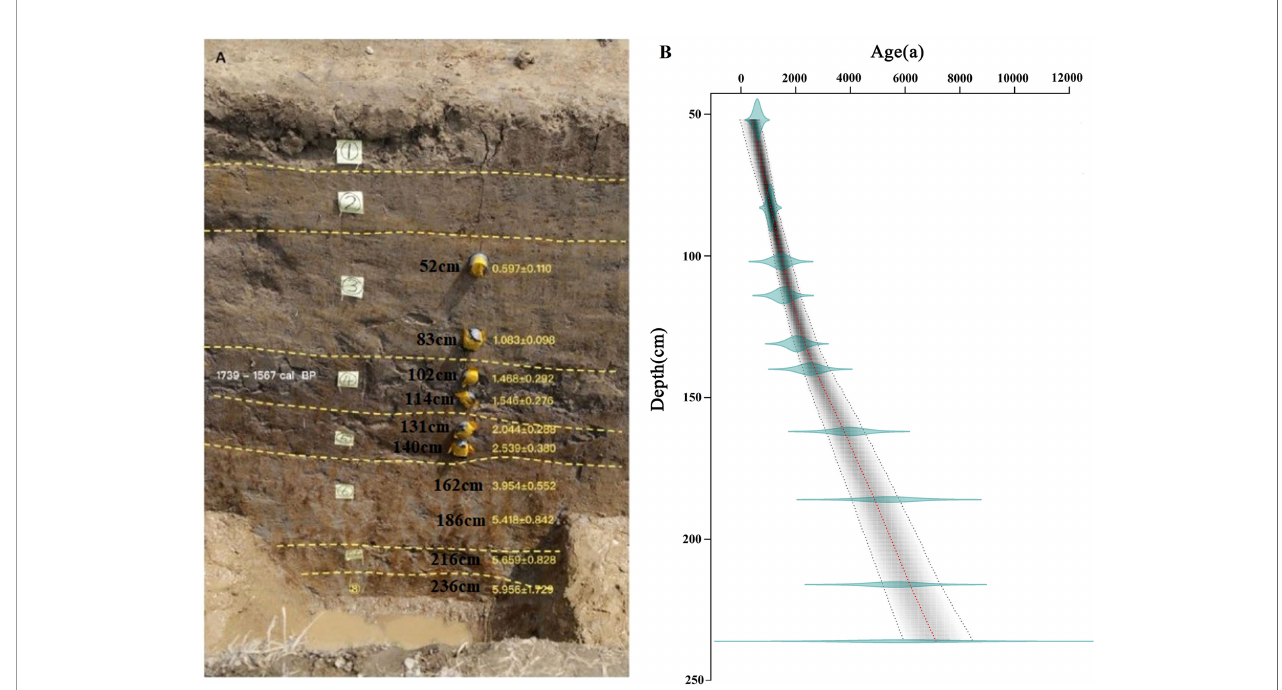
FIGURE 2 | Stratigraphy (A) and age-depth model (B) of the GGL